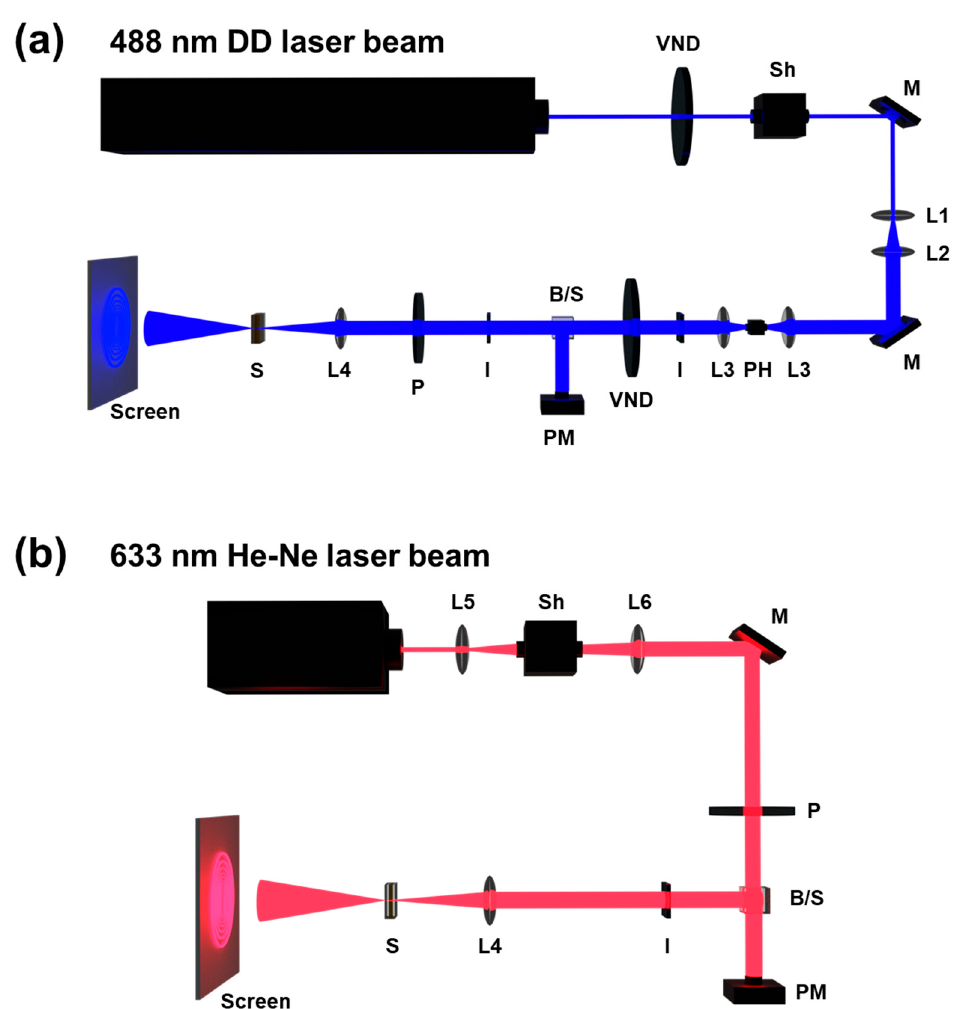
Figure 4. Schematic representation of the optical setup used in this study. ( a ) Linearly polarized direct diode (DD) laser beam optical setup for nonlinear molecular reorientation and fabrication of a microlens array and ( b ) linearly polarized He-Ne laser beam optical setup for confirming the molecular reorientation in the fabricated microlens array. VND, variable neutral density; Sh, shutter; M, mirror; L1, plane concave lens ( f = − 8 cm); L2, plane convex lens ( f = 20 cm); L3, plane convex lens ( f = 7.5 cm); PH, pinhole; I, iris; PM, power meter; B/S, beam splitter; P, polarizer; L4, bi-convex lens ( f = 15 cm); L5, plane concave lens ( f = − 12 cm); L6, plane convex lens ( f = 30 cm); S, sample glass cell.